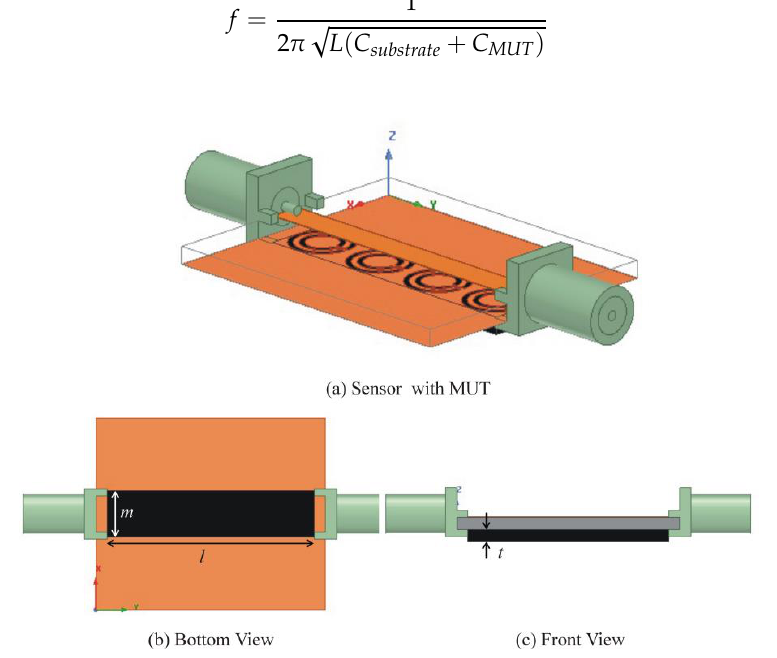
Figure 8. ( a ) Sensor based on four CCSR with materials under test (MUT) in the ground plane without air gap. ( b ) Bottom view of the sensor with MUT ( l = 27 mm, and m = 6 mm). ( c ) Front view of the sensor with MUT ( t = 1 mm).